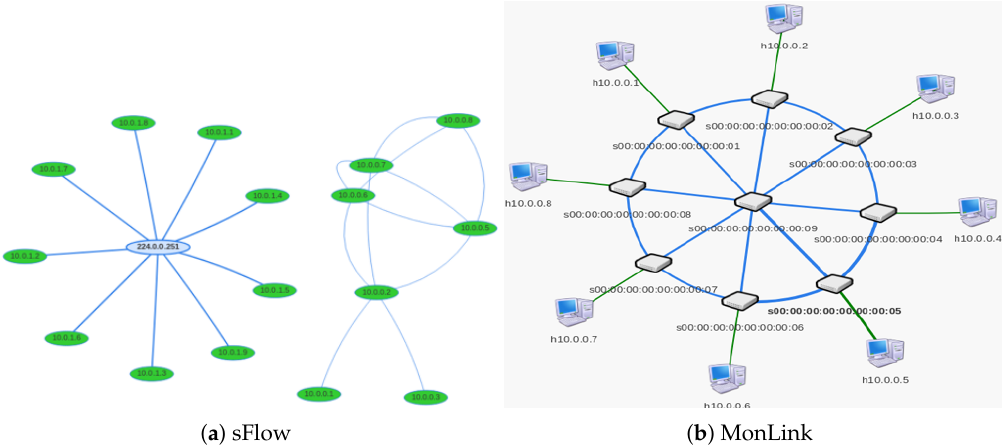
Figure 6. Topology discovery: sFlow v.s.